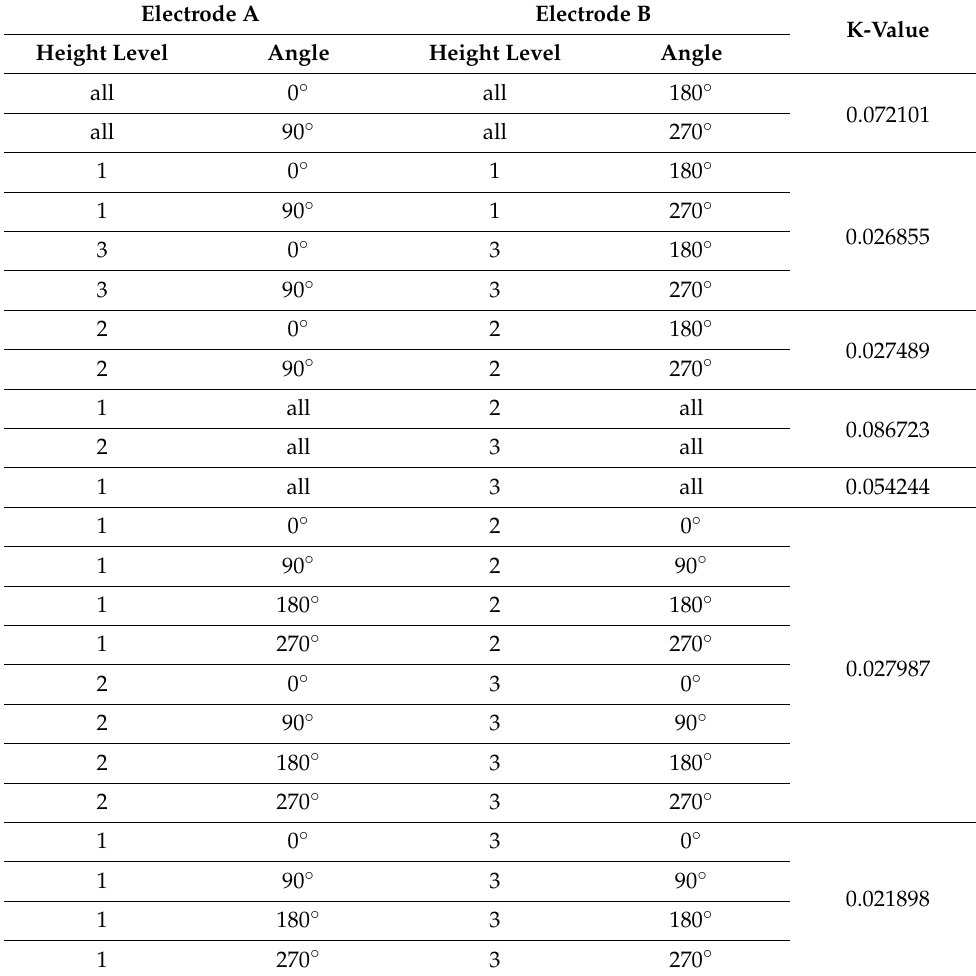
Table A2. Geometry factors k for the validation tests of the test setup, calculated by Comsol, with an electrode array with angular distances of 90 ◦ and the electrical conductivity of the electrodes in Comsol model of titanium of 2.5 × 10 6